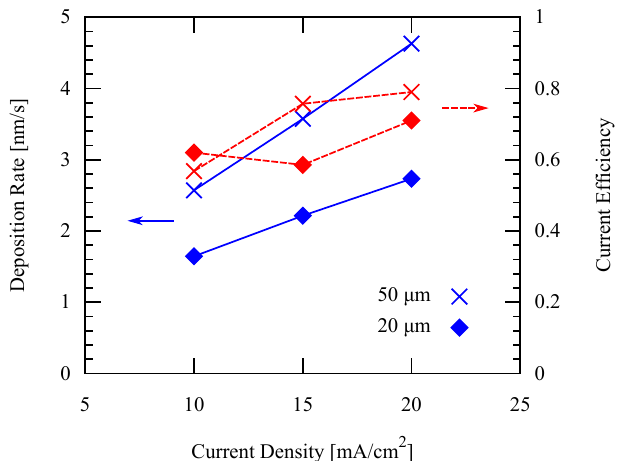
Figure 10. Deposition rate and current efficiency using different current densities applied with different pattern